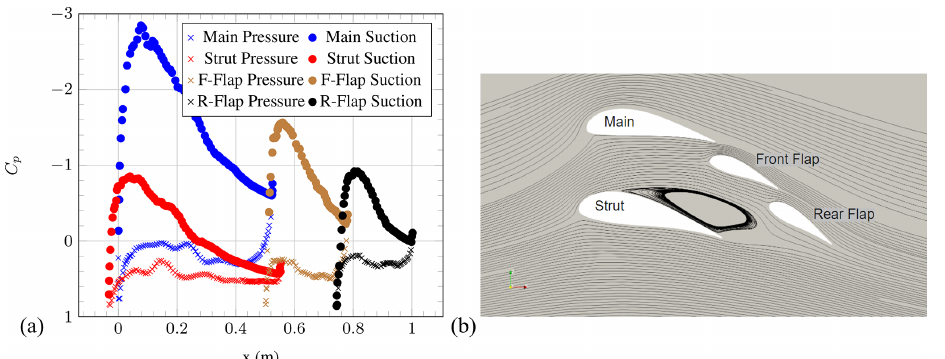
Figure 11. (a) Pressure coefficient of the individual element airfoils and (b) streamlines at AoA = 25 ◦ (OpenFOAM simulations).